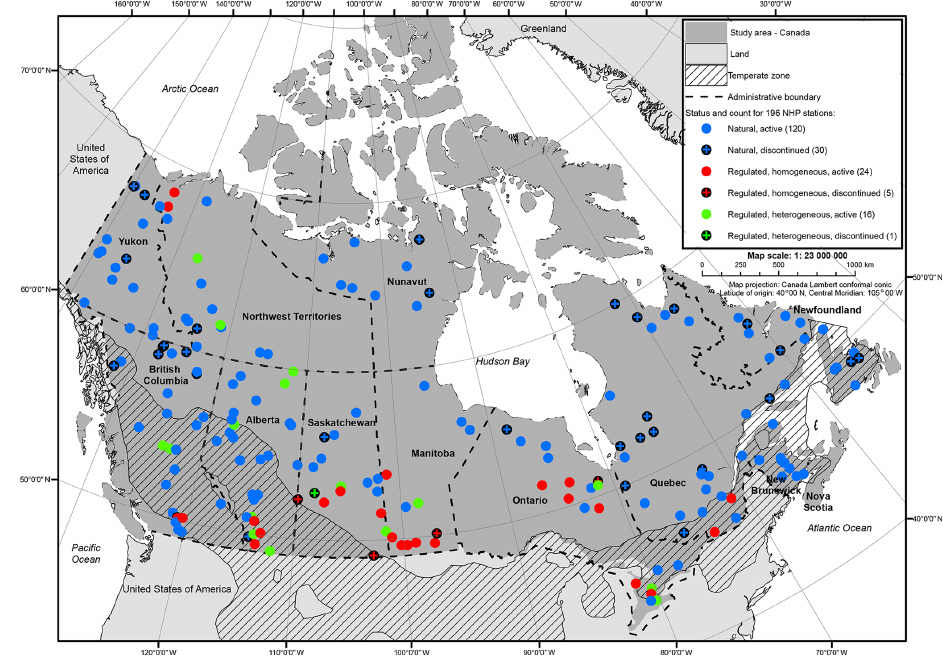
Figure 1. Location of the 196 National Hydrometric Program (NHP) hydrometric gauging stations included in the Canadian River Ice Database. Status and count for the stations are based on flow condition (natural or regulated), whether they are active (in operation up to end of 2015) or discontinued, and if the flow condition is homogeneous (always regulated) or heterogeneous (regulated during specific period of